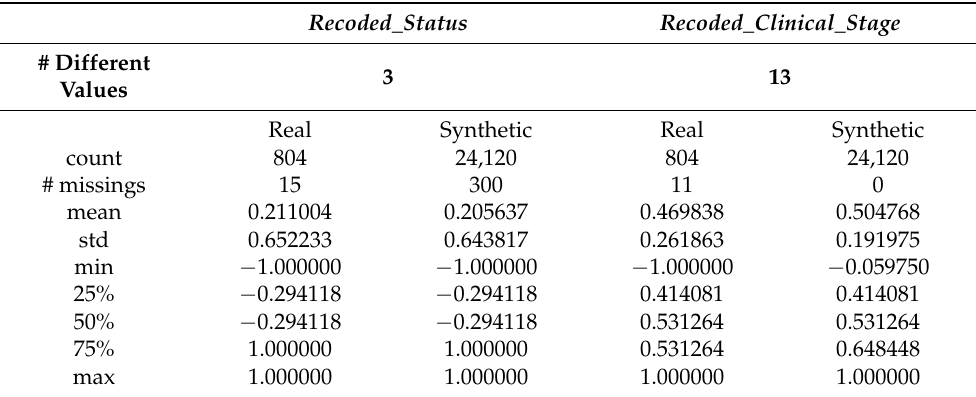
Table 5. A summary of the statistics of the ‘Recoded_Status’ and ‘Recoded_Clinical_Stage’